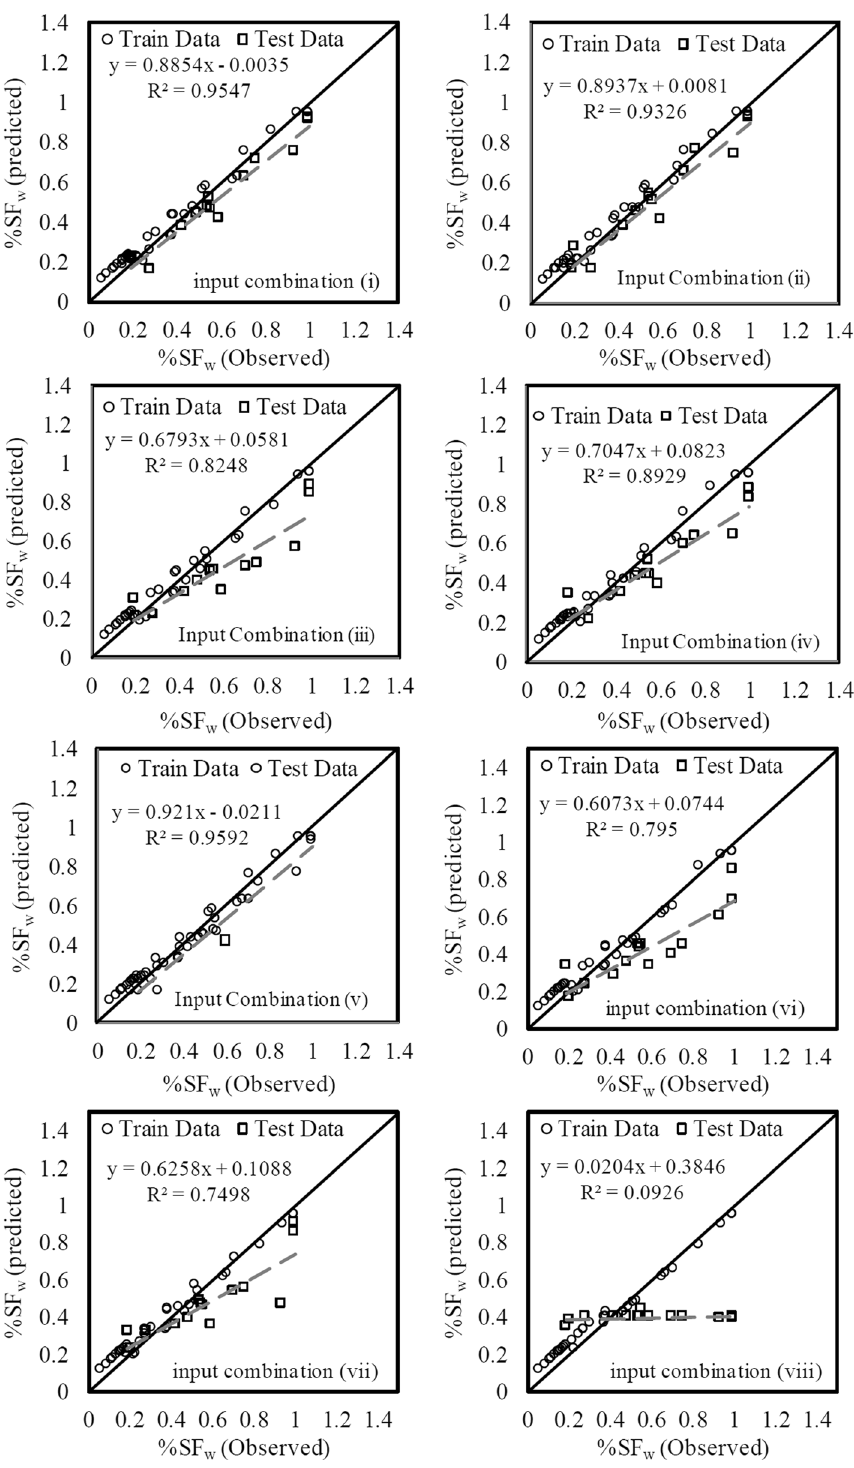
Fig. 2 SVR model with various input combinations for test